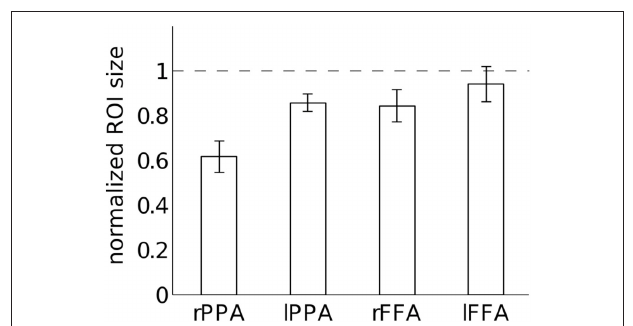
FIGURE 9 | Quantification of large vein contributions to specific ROIs. Normalized ROI size after large vein suppression is calculated for each ROI as the ratio of ROI size with vs. without sPR large vein suppression. sPR significantly reduces ROI size for right PPA, left PPA and right FFA ( p < 0.05 ). Specifically, 38 ± 7% of right PPA, 14 ± 4% of left PPA, 16 ± 7% of right FFA, and 6 ± 8% of left FFA voxels predominantly reflect signal from large draining veins. Error bars are SEM across